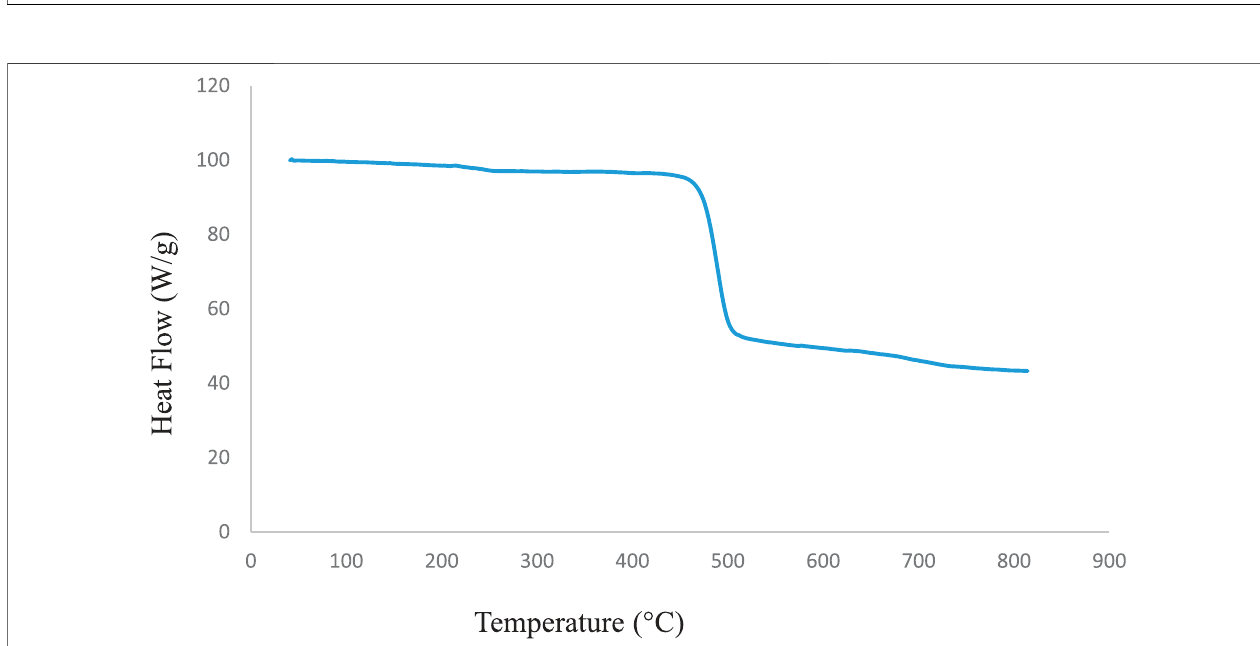
FIGURE 7 | Thermal stability of Y-MOF synthesized under the optimal condition of the microwave route.